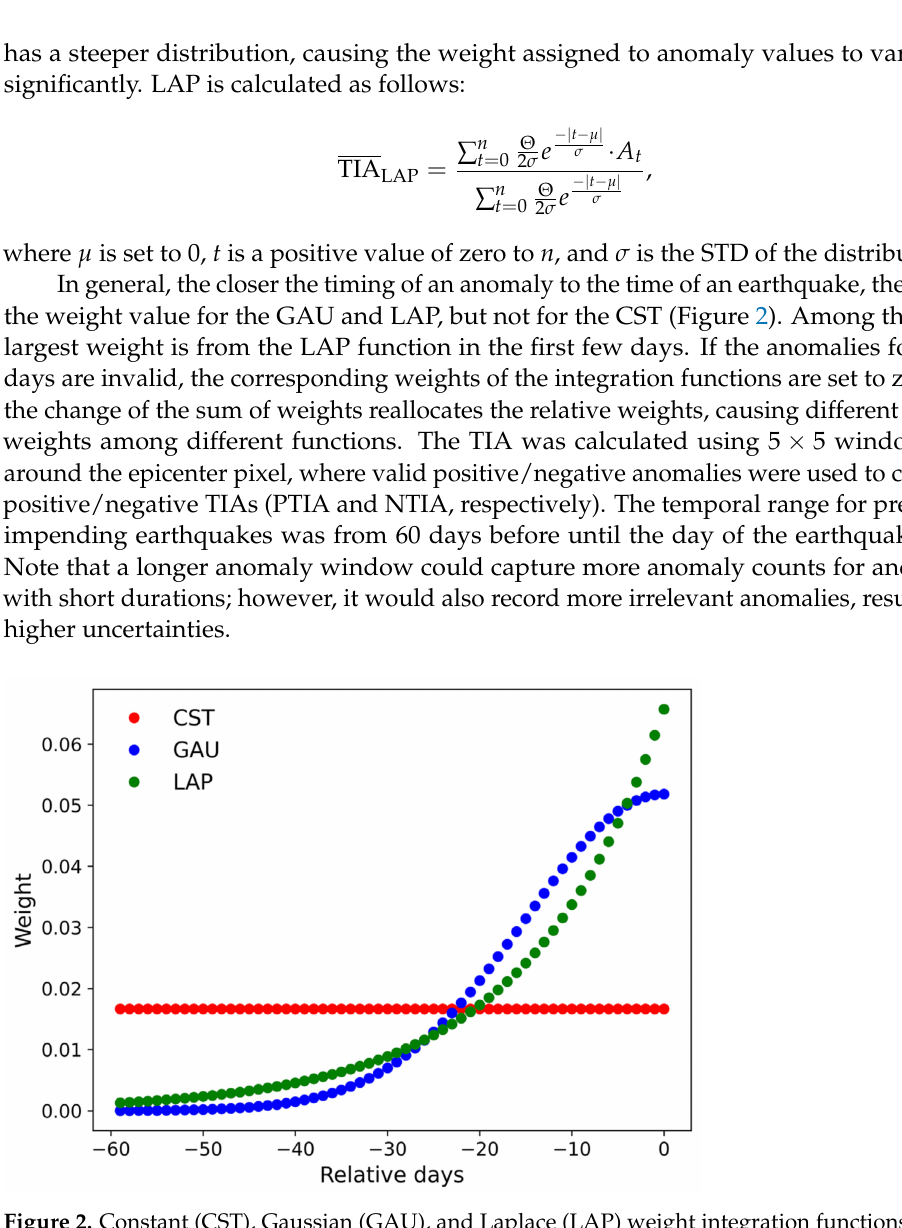
Figure 2. Constant (CST), Gaussian (GAU), and Laplace (LAP) weight integration functions used in the temporal integrated anomaly (TIA) calculation within a 60-day interval. In the LAP and GAU functions, µ is set to 0 and σ is 15. The red, blue, and green dots denote GAU, LAP, and CST weight integration functions,